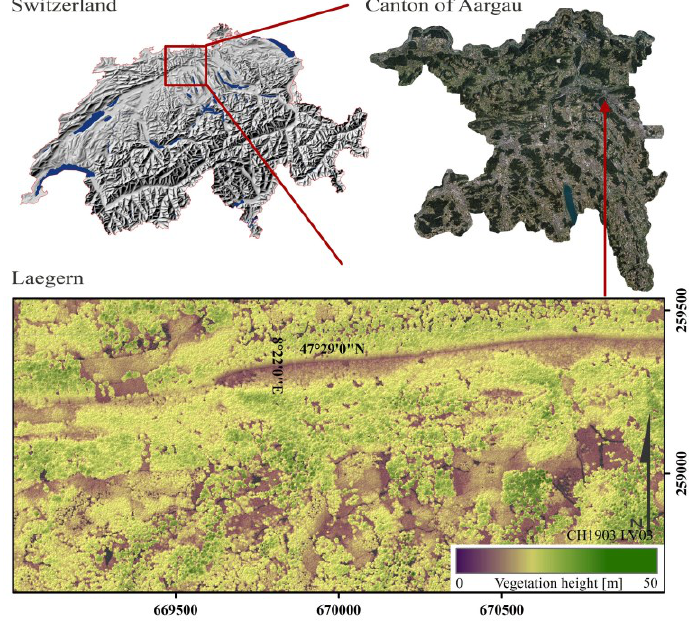
Figure 1. Switzerland (left) and the location of Canton of Aargau (right, top panel). Laegern experimental site (800 ha forested area) plotted against ALS-derived canopy height (bottom